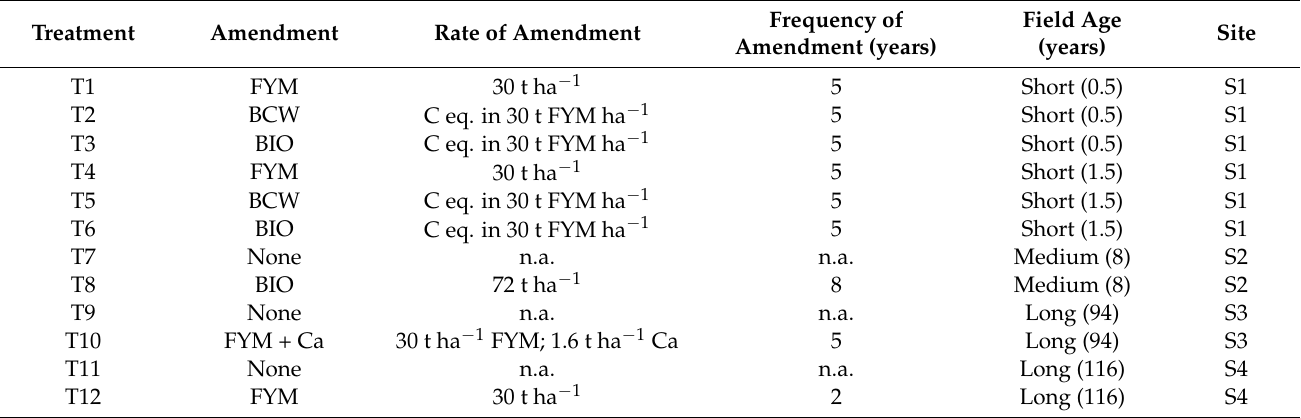
Table 2. Description of experimental sites and